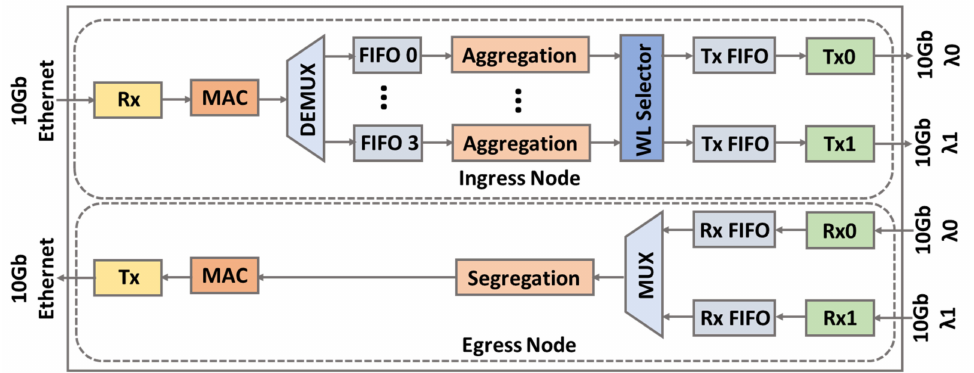
Figure 4. The time shared optical network (TSON) edge node baseline data plane